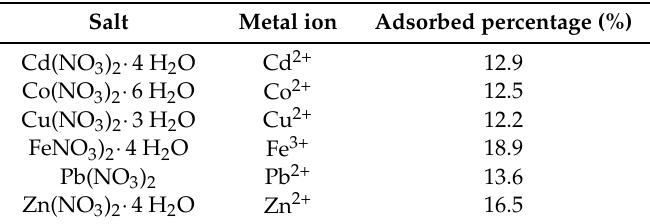
Table 3. Adsorbed percentage of other metal ions from electrospun fibers. The procedure was identical to the mercury(II) adsorption after 60 min.